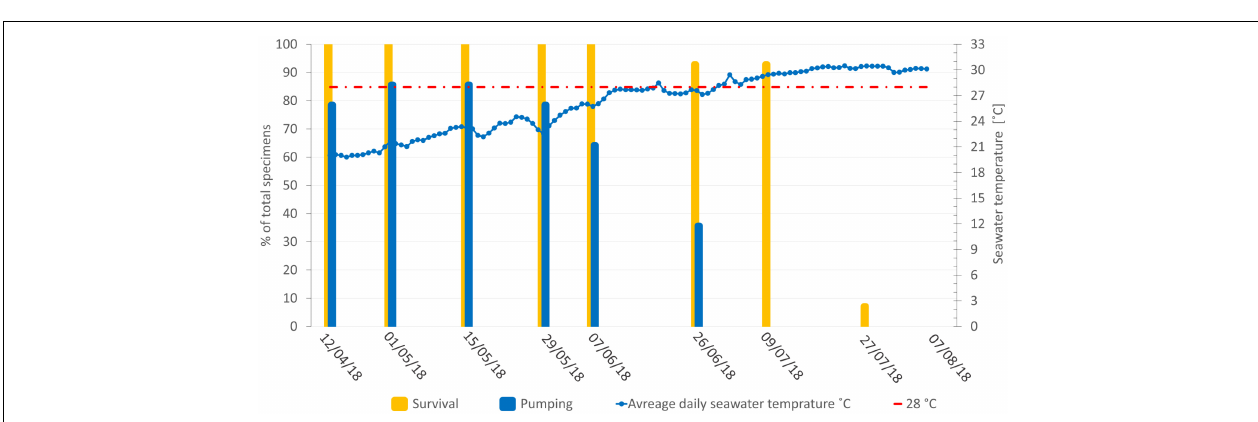
FIGURE 5 | Concentrations of organic carbon and total nitrogen at the mesophotic and transplantation sites over time (01–10/2018). At 10 m, the first three dates have only one sample for TN and TOC, and the same for the first two dates for POC. (A) Total nitrogen (TN; µ M), (B) Total organic carbon (TOC; µ M), and (C) Particulate organic carbon (POC; µ M).